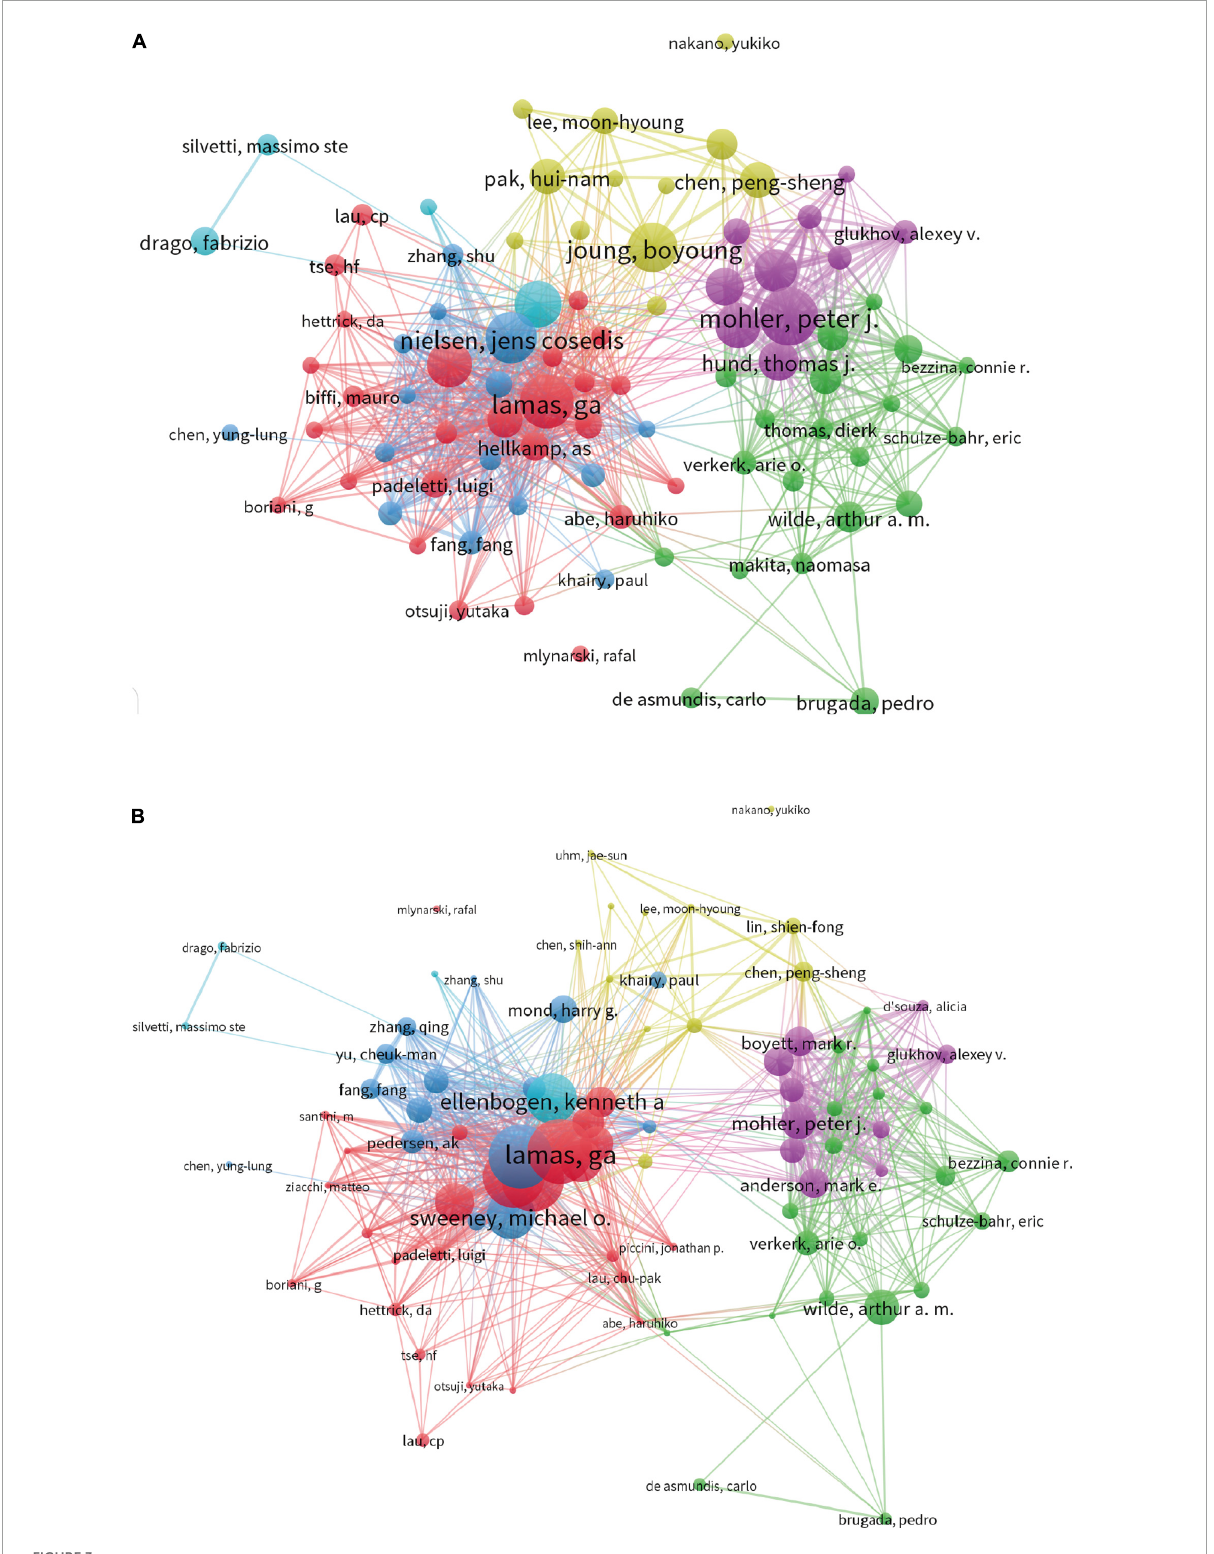
FIGURE3 (A) Network map of authors analysis based on VOS viewer. (B) Network map of citation authors analysis based on VOS